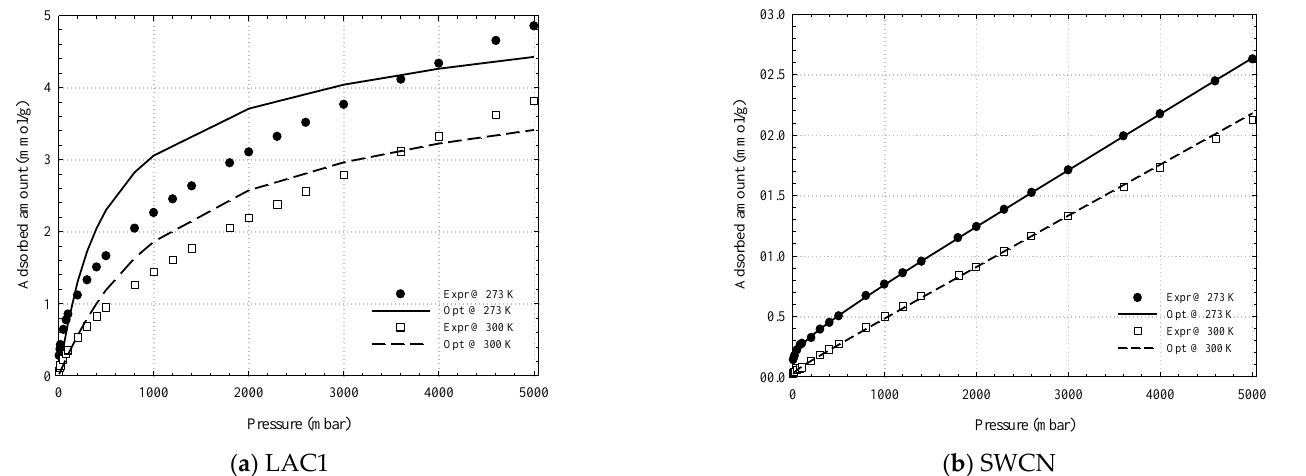
Figure 18. Comparison between the experimental data and reconstructed adsorption isotherms obtained from PSD deter- mination for LAC1 ( a ) and SWCN ( b ) using the adsorption isotherms of CO 2 at 273 and 300 K .